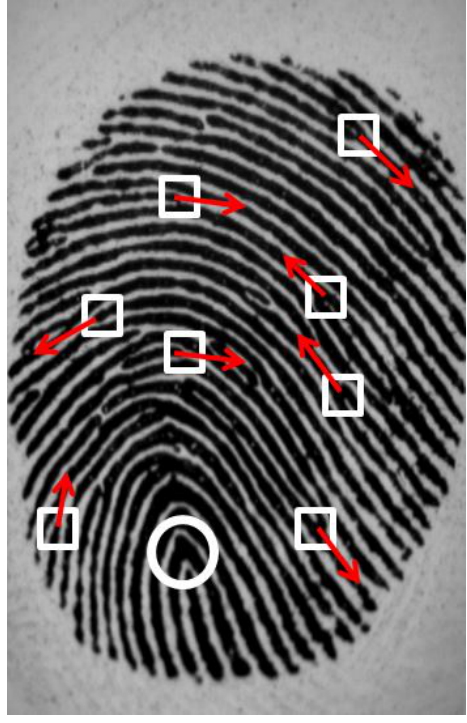
Figure 1. A singular point (circle) and minutiae points (squares are minutiae points and arrows are their orientations) in a